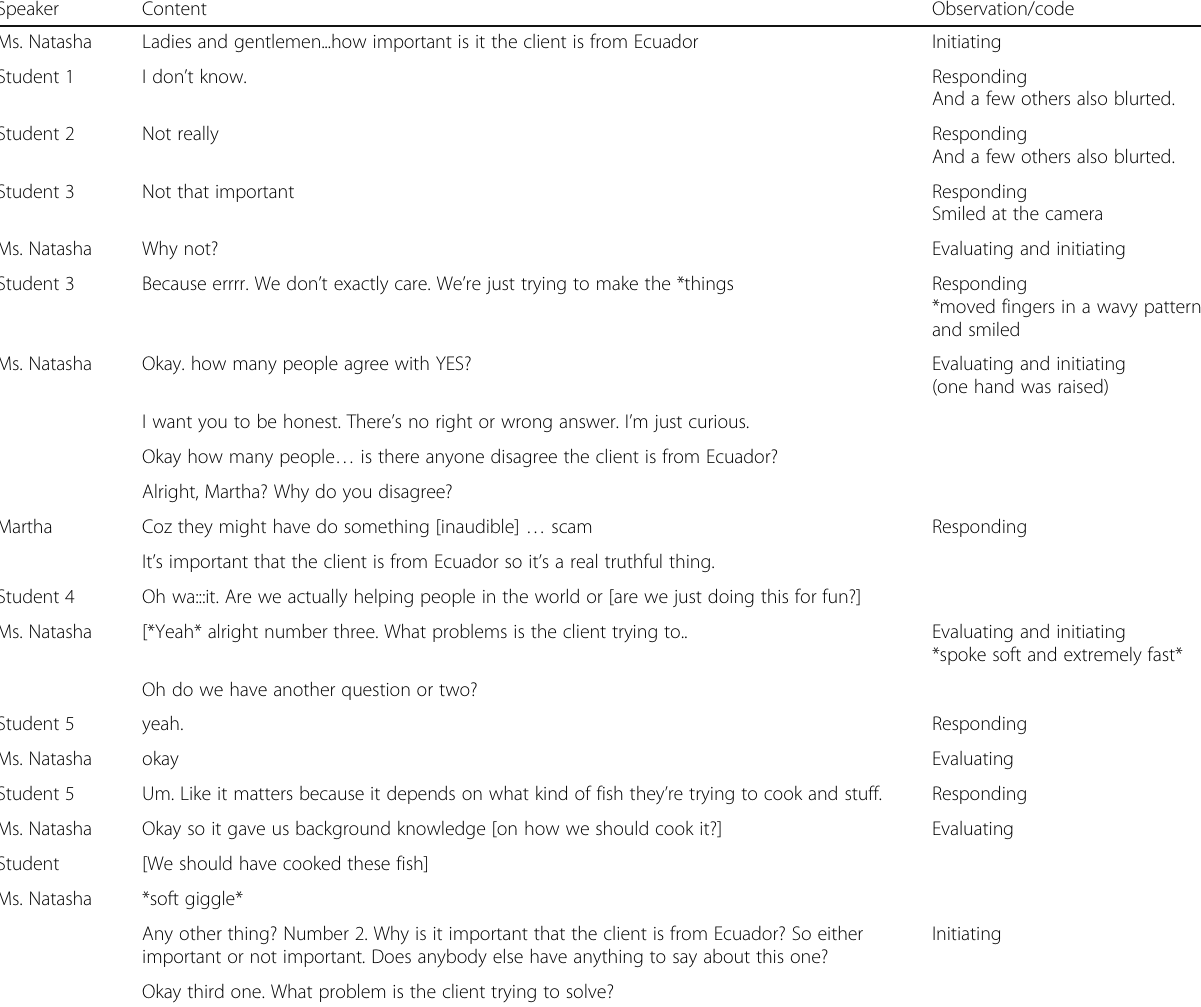
Table 5 Conversation between Ms. Natasha and her students during the last day of the unit in lesson 12 Speaker